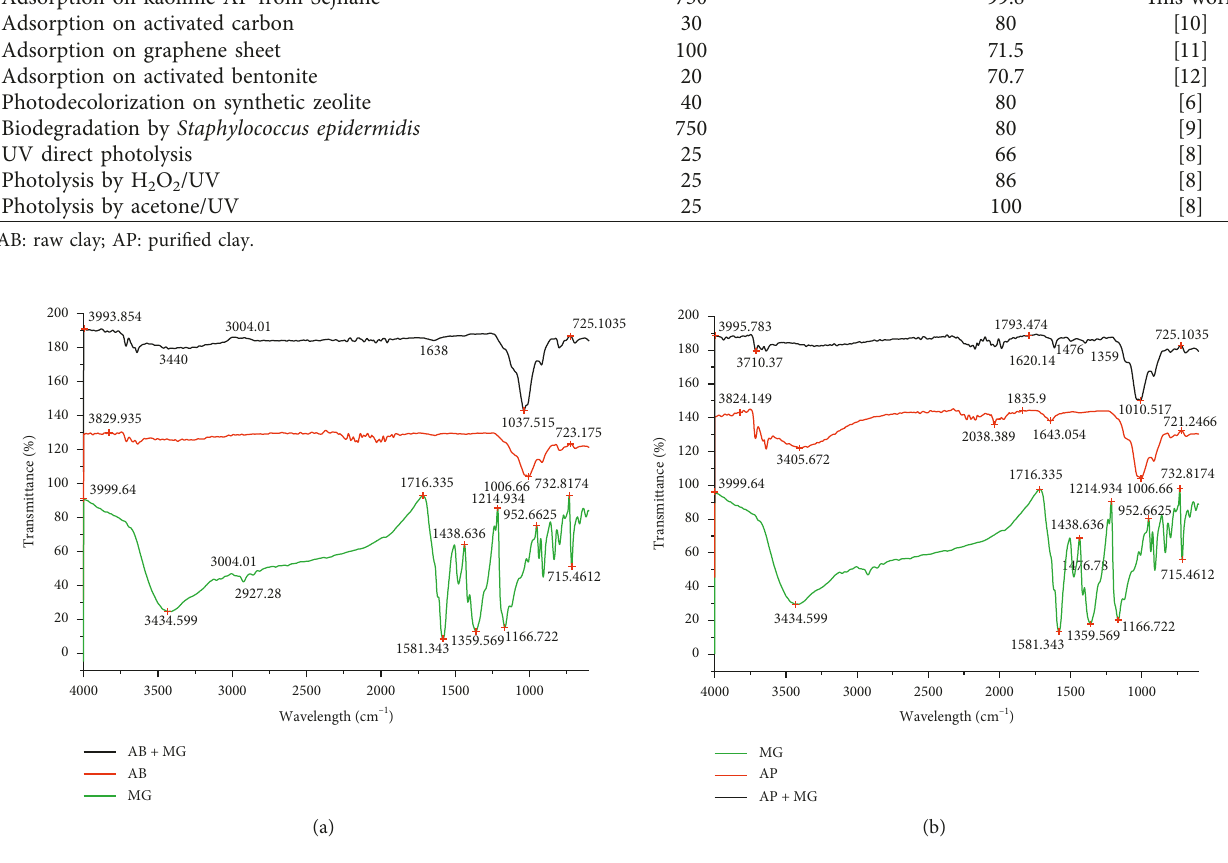
Figure 17: FTIR spectrum of MG and clays used before and after adsorption.